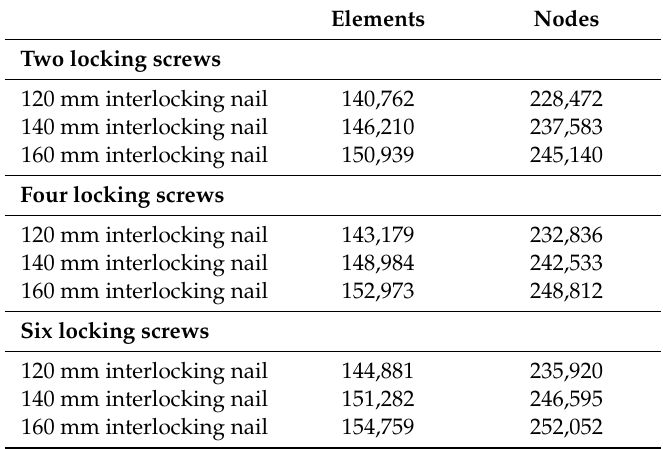
Figure 6. A 160 mm meshed composite interlocking nail with 4 screws and a canine femur bone/nail assembly. Table 6. All elements and nodes of each interlocking nail system.